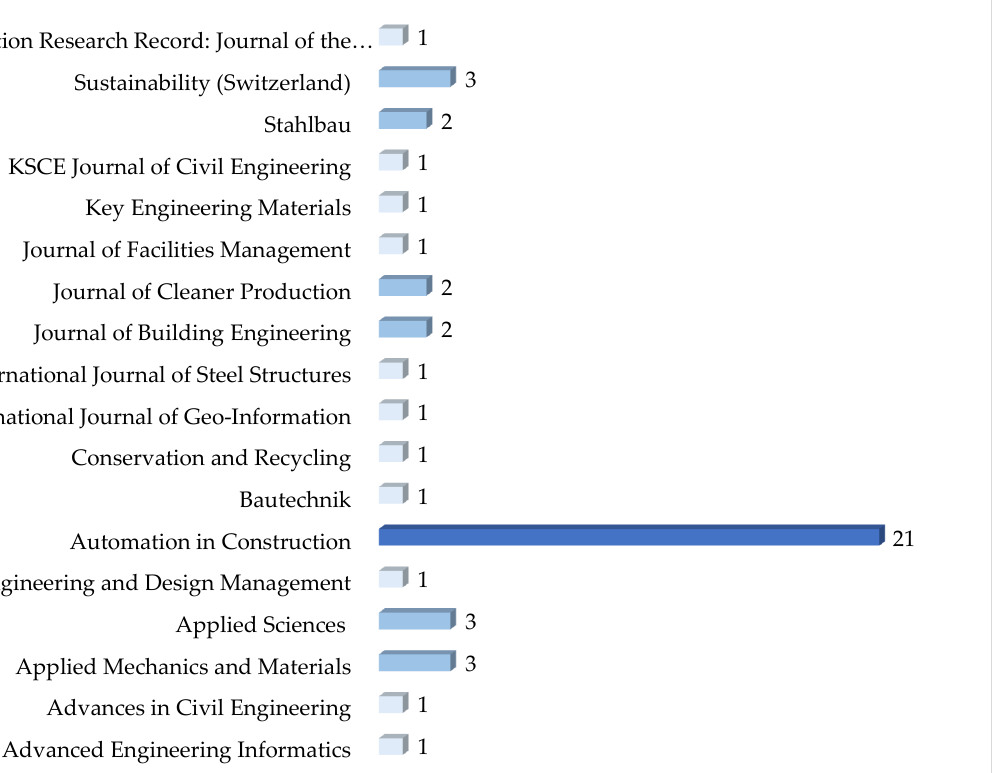
Figure 3. Evolution of the research literature review.